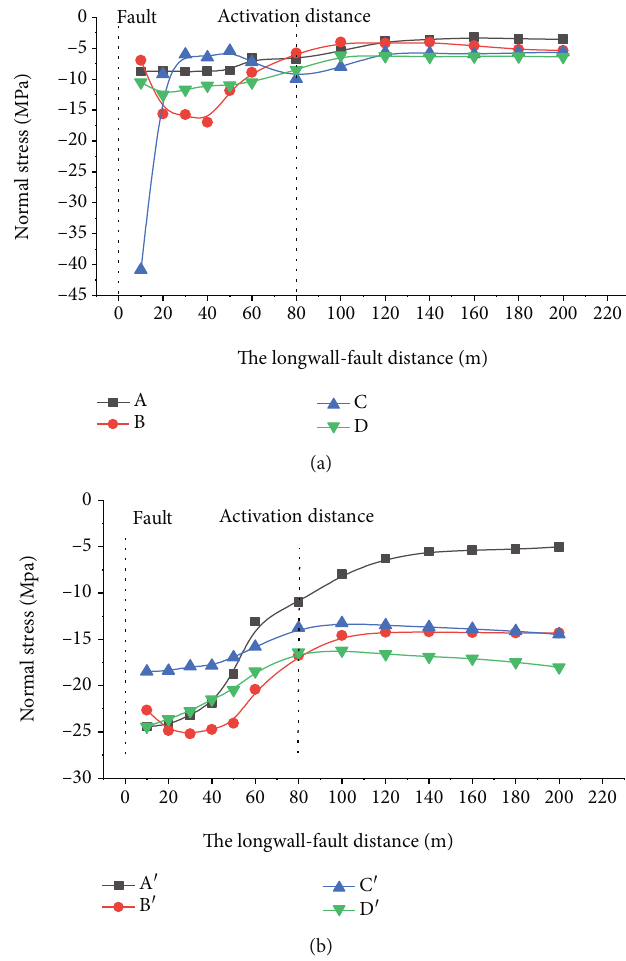
Figure 8: Normal stress changes at eight monitoring